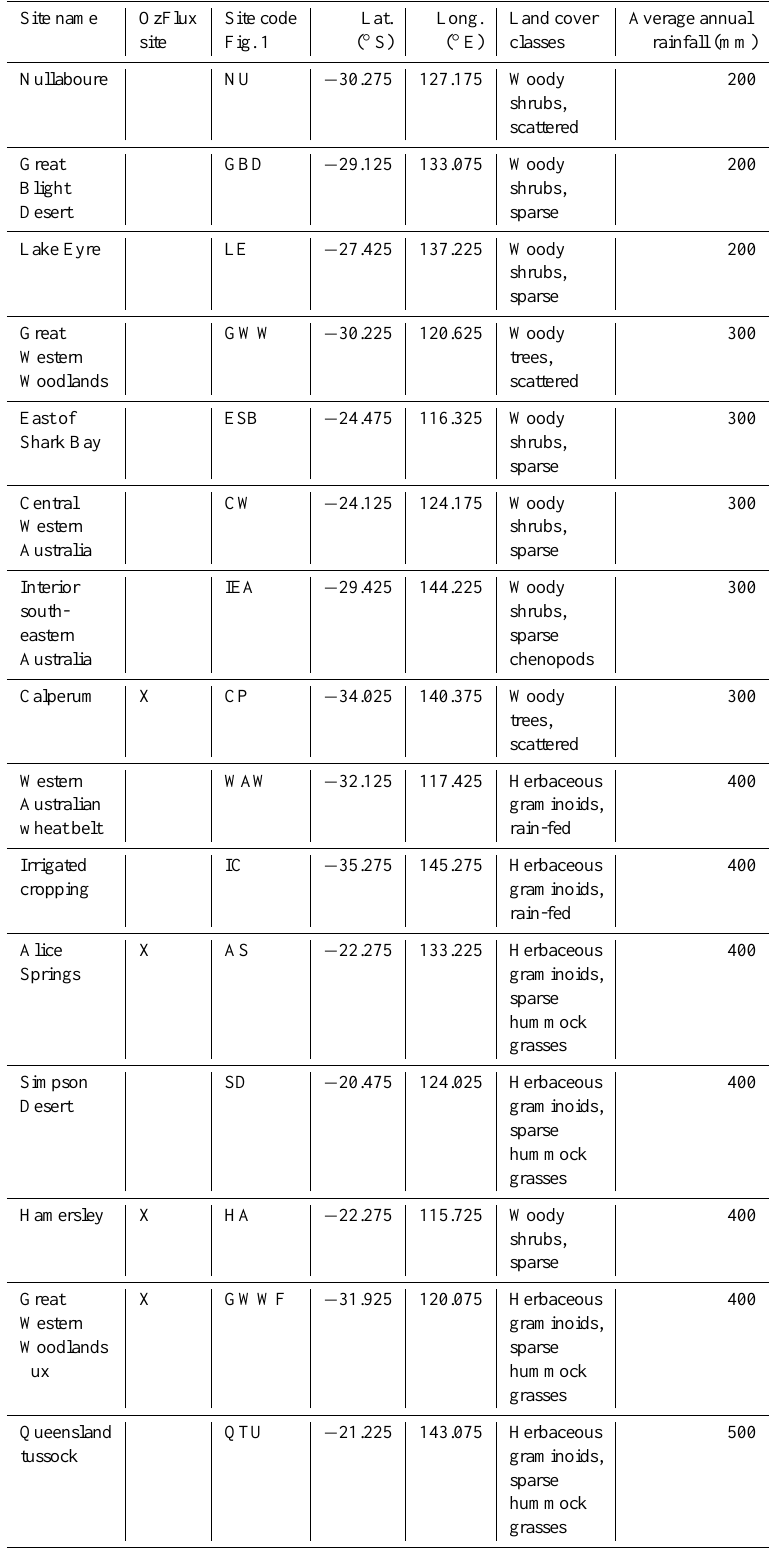
Table 1. Names, locations, land cover class (Lymburner et al., 2011) and average annual rainfall amounts (Australian Bureau of Meteorology, 2014c) for the 36 sites shown in Fig.